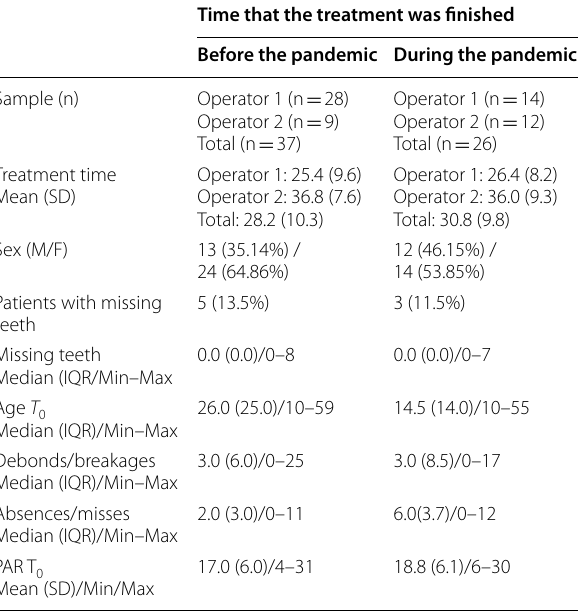
Table 1 Descriptive analysis. Sample distribution, mean (SD), median (IQR) and minimum/maximum values for the variables